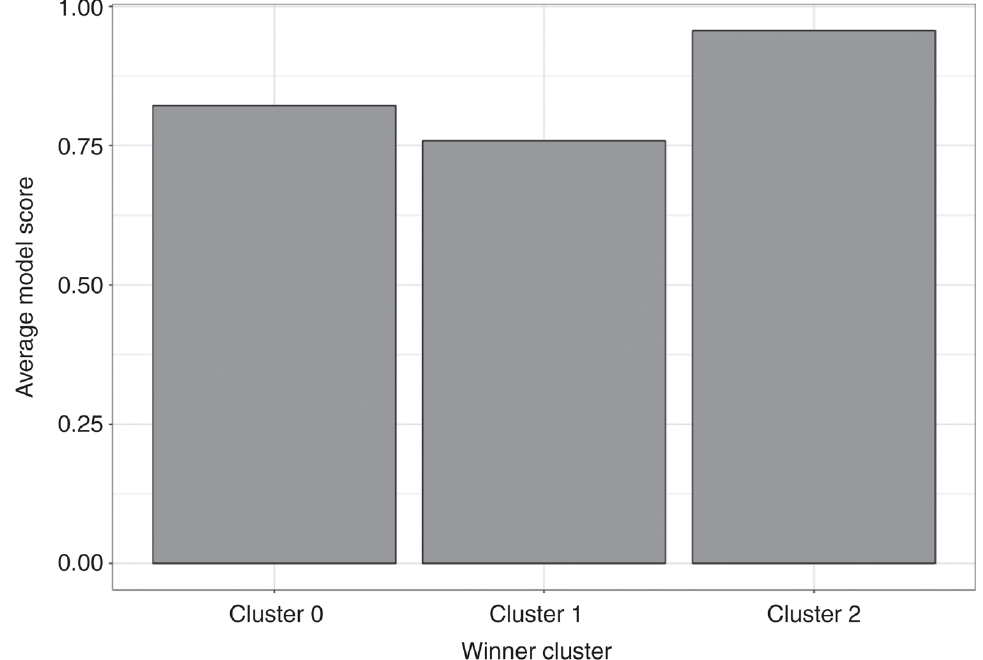
Figure 2: Left box whisker plot shows the model prediction score distribution for 5449 miRBase hairpins randomly sam- pled from 23,195 with a maximum RPM value of 100 (Minimum: 0.014, Lower whisker: 0.572, Lower quartile: 0.823, Me- dian: 0.976, Upper quartile: 0.990, Upper Whisker: 0.992, Maximum: 0.992). The right part shows the distribution of the model prediction scores for 5449 hairpins with RPM values greater than 100 (Minimum: 0.015, Lower whisker: 0.785, Lower quartile: 0.909, Median: 0.986, Upper quartile: 0.991, Upper Whisker: 0.993, Maximum: 0.993).